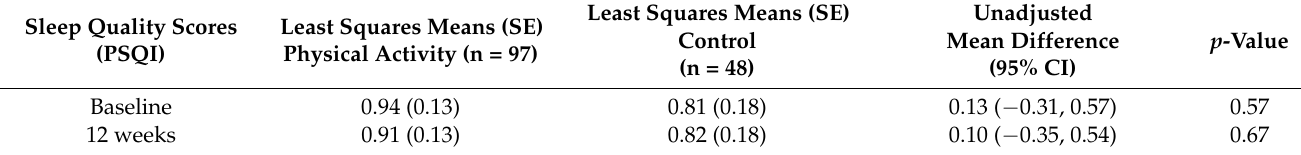
Table A1. Subjective Quality